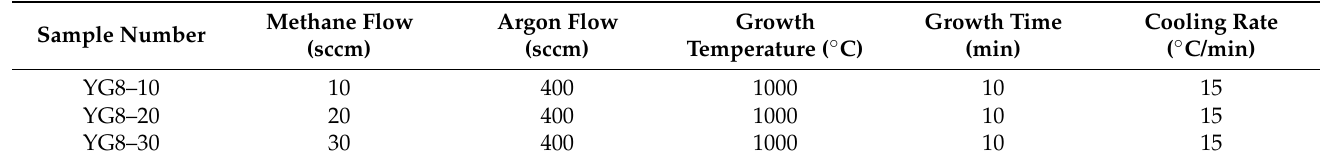
Table 4. The process parameters of friction